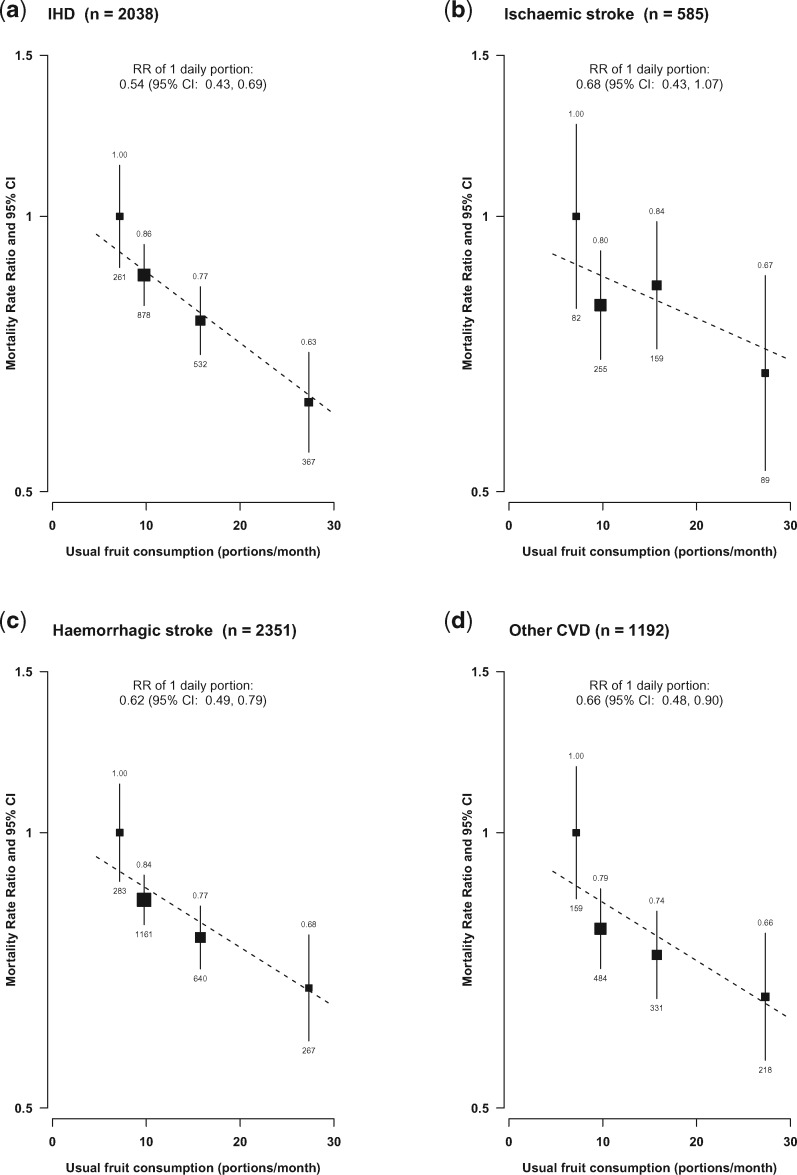
Adjusted RRs for mortality from CVD subtypes by levels of fresh fruit consumption. Conventions as in Figure 2.